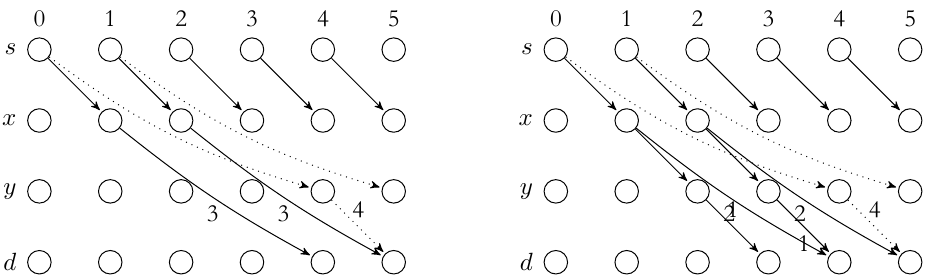
Figure 3: The maximum dynamic flow and earliest arrival flow solutions, respectively, in the time-expanded networks corresponding to Figure 1(b), with source node s , sink node d , and intermediate nodes x and y . ⌉ ⌈ T is integer, then any flow over time in T and a static flow of equal cost in N ∆ ( T ) interval [ (cid:26) ∆ ; ( (cid:26) + 1)∆) . If ⌉ ⌈ ∆ T , any flow in N ∆ ( T ) corresponds to a flow over time of equal are equivalent. However, for non-integer time ∆ value that completes before time T + ∆ . However, as the transit times are rounded up in N ∆ ( T ) , its maximum flow approximates the maximum flow of an optimal solution in the original setting and it can be transformed into a flow over time with original arc lengths without too much loss in flow value Fleischer and Skutella (2007). Only two paths